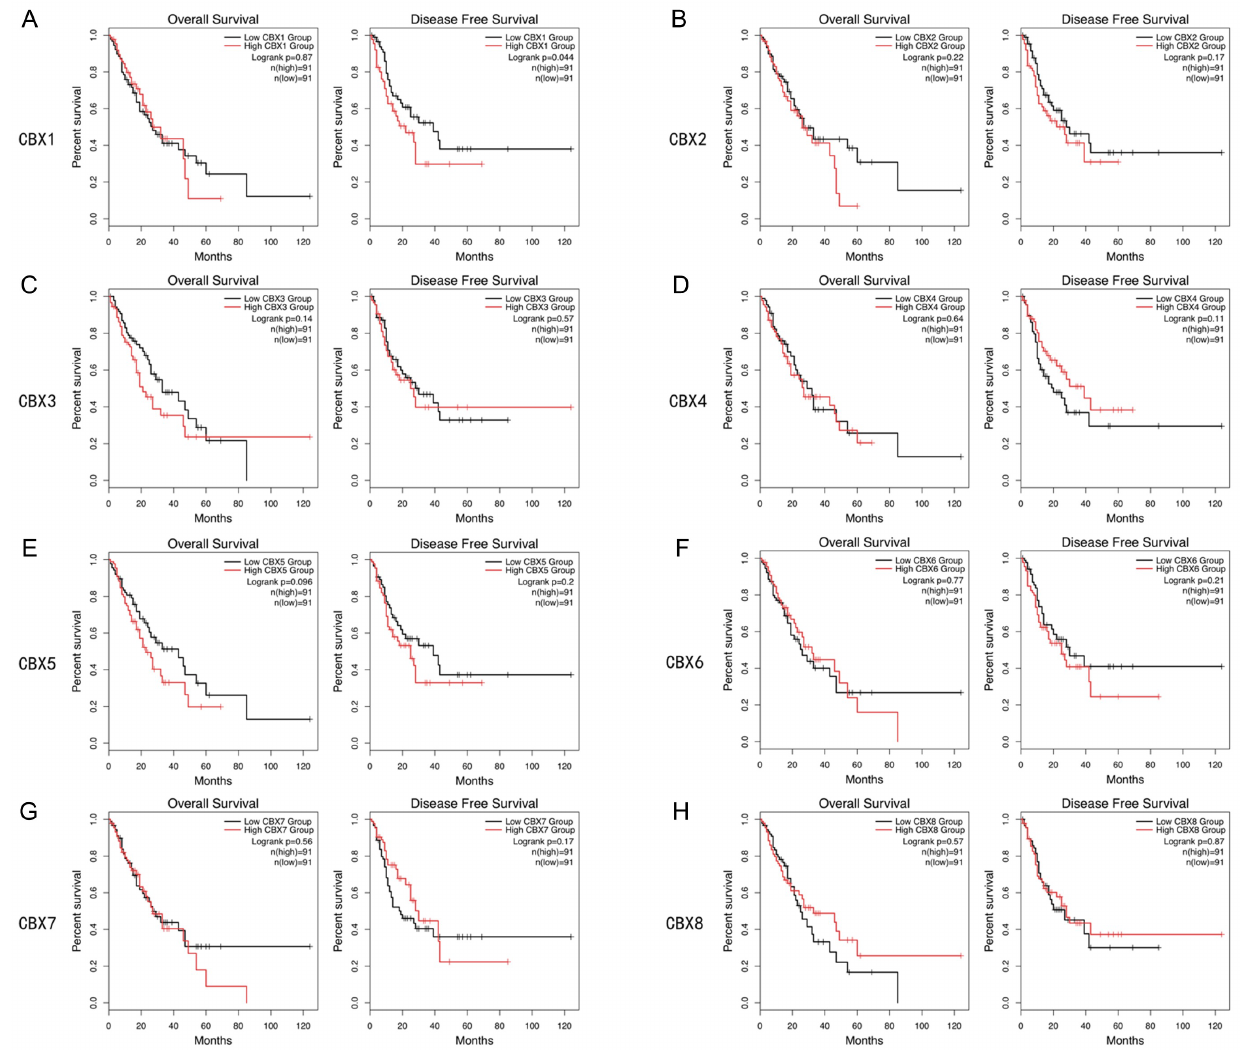
Figure 4. Prognostic value of CBX family proteins in EC patients ( A – H ). (GEPIA2, p < 0.05 was considered statistically